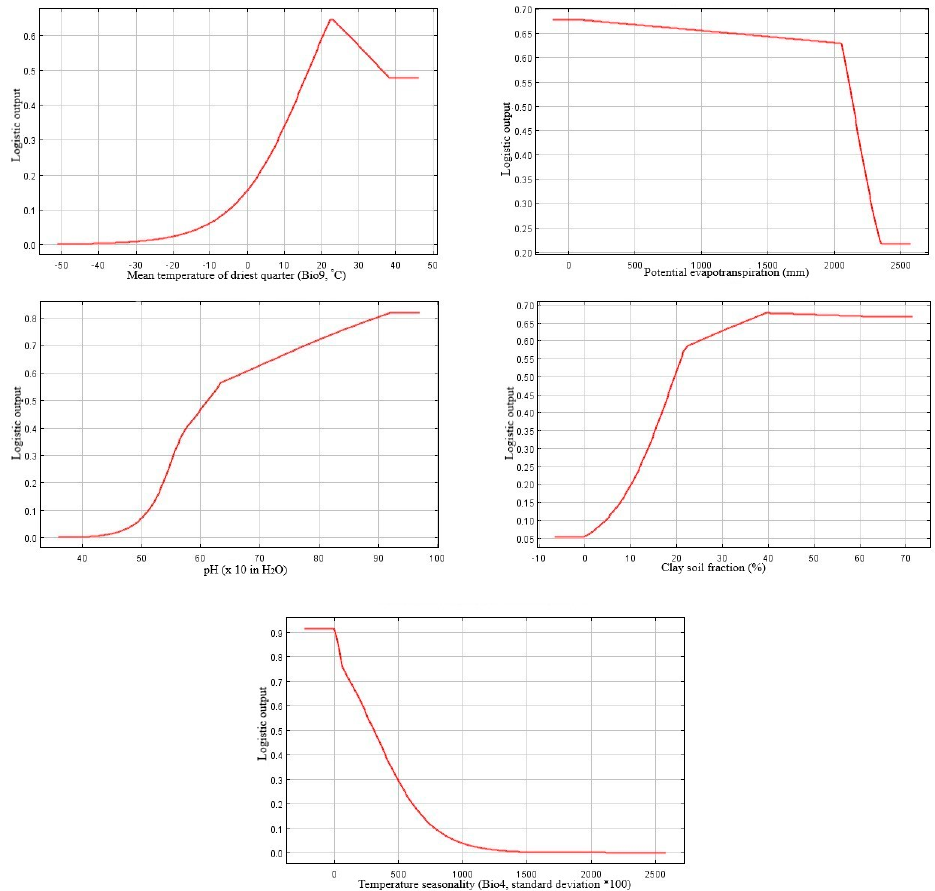
Figure 3. Response curves of the most influential climatic and edaphic predictors generated by MaxEnt (Climate + Soil